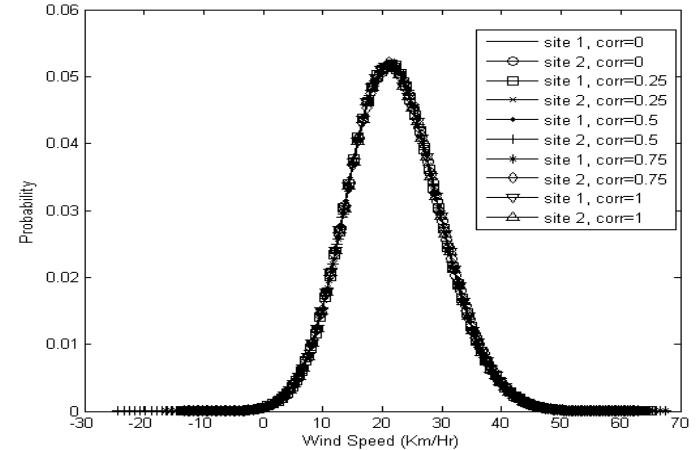
Figure 5. Probability distribution of wind speeds simulated at different